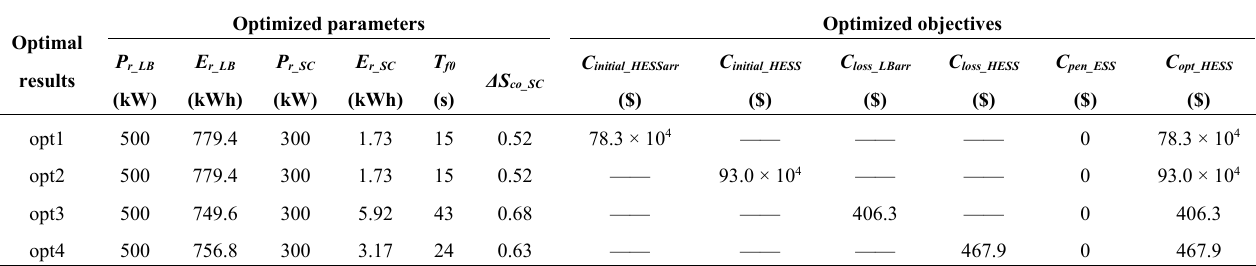
Table 3. Optimal results of four different considerations in cost and life.